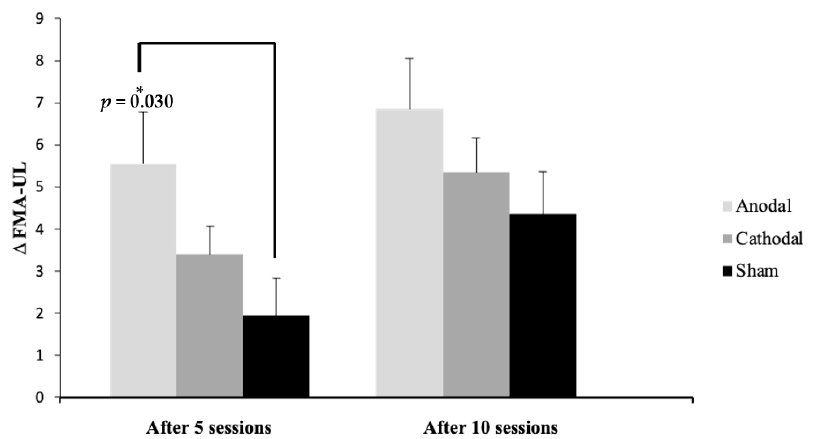
Figure 3. Mean and standard deviation (SD) of the ∆ (difference from baseline) of Fugl-Meyer As-